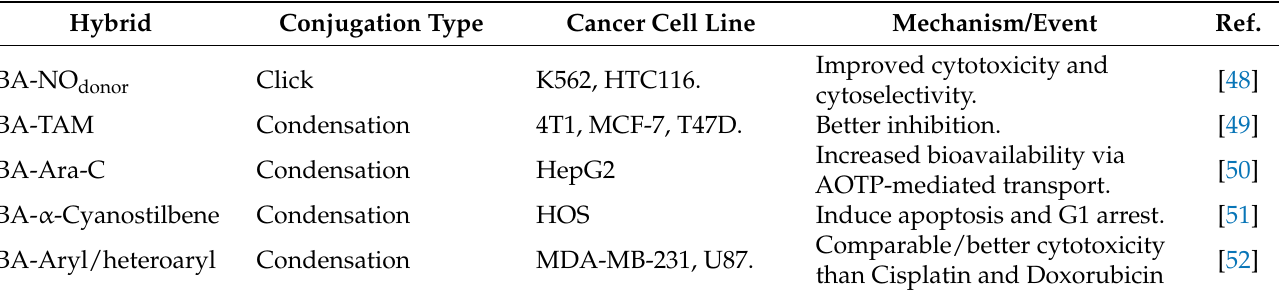
Table 4. Summary of BA